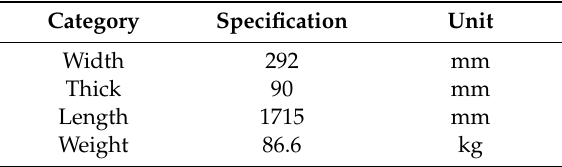
Table 4. Specifications of the 2170 battery cell